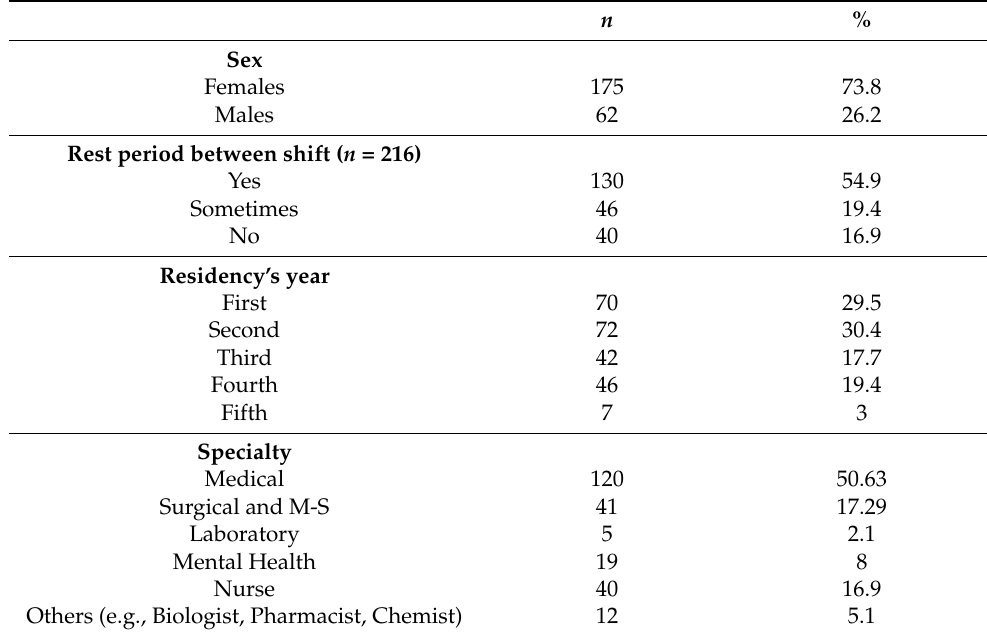
Table 1. Participants’ sociodemographic characteristics and working